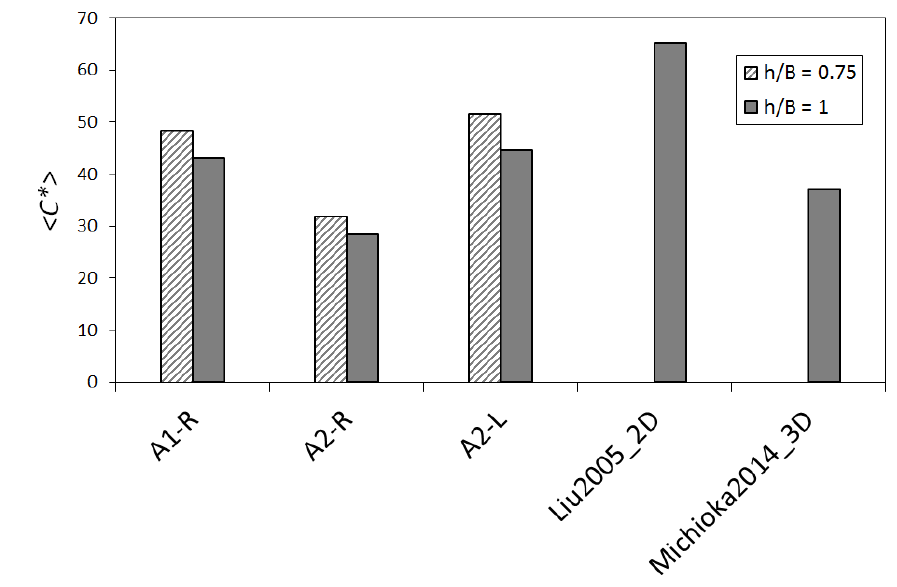
Fig. 3. Spatially-averaged pollutant concentration for all investigated canyons. In the canyons A1-R, A2-R, and A2-L the aspect ratio h/B = 0.75 and h/B = 1 corresponds to averaging over the volume V = h 1 LB = 0.6 HLB and V = h 2 LB = 0.8 HLB , respectively. The study of Liu et al. [10] on 2D street canyon and study of Michioka et al. [16] on 3D stand-alone street canyon is added for